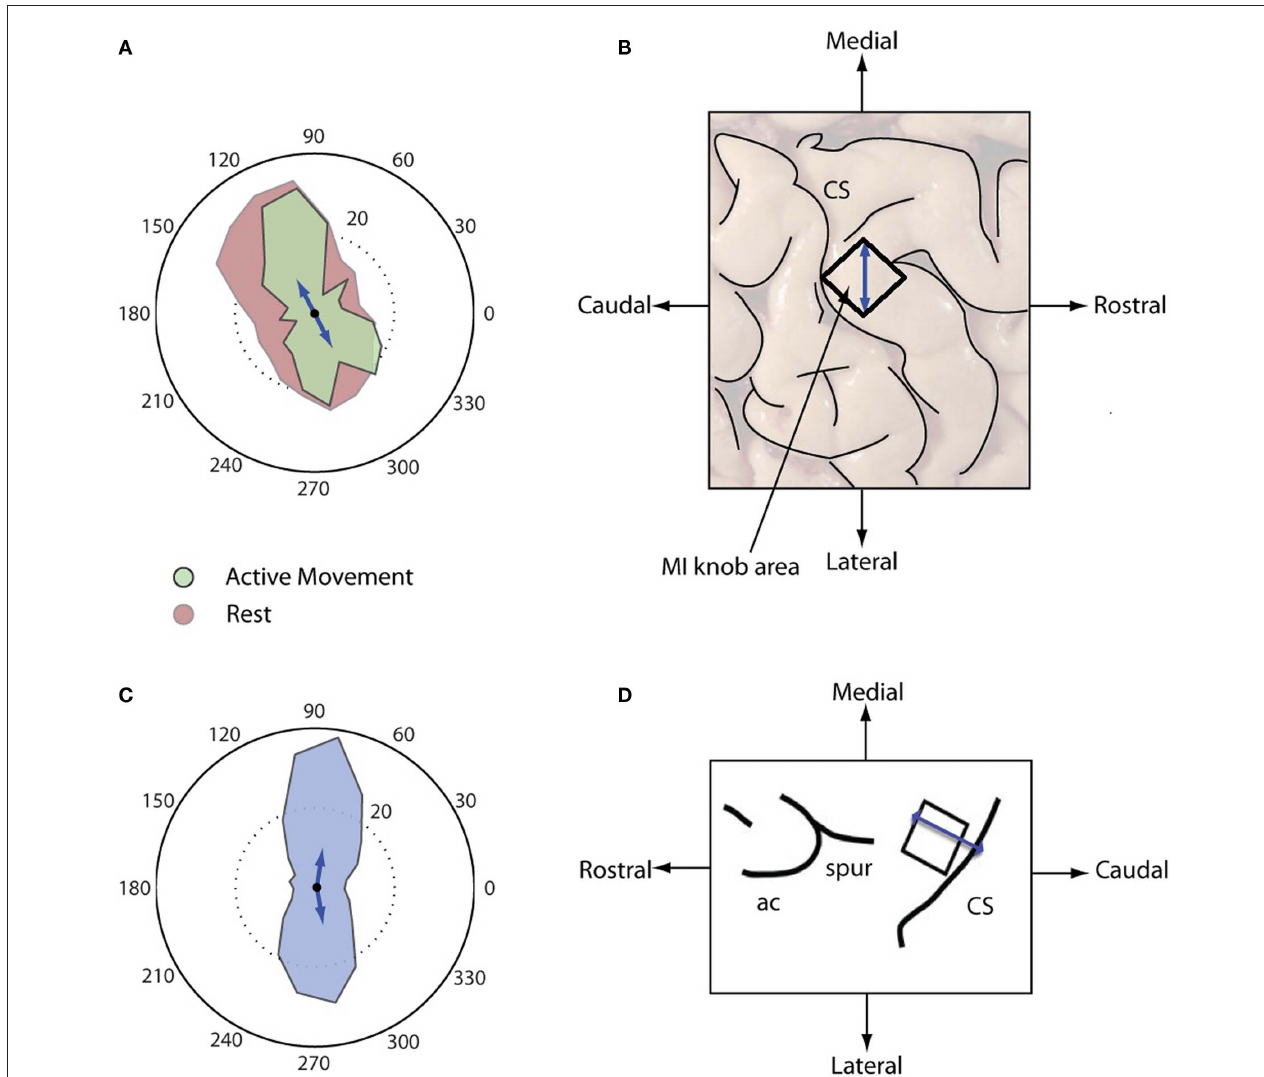
arrow in (A) . The black square denotes the location of the array. (C) Direction of sustained beta waves. (D) Dominant propagation directions of the beta wave mapped on the NHP subject cortical surface (modified from Figure 1 for Monkey R in O’Leary and Hatsopoulos, 2006) CS, central sulcus; ac, arcuate sulcus; and spur, spur of the arcuate sulcus. The black square denotes the location of